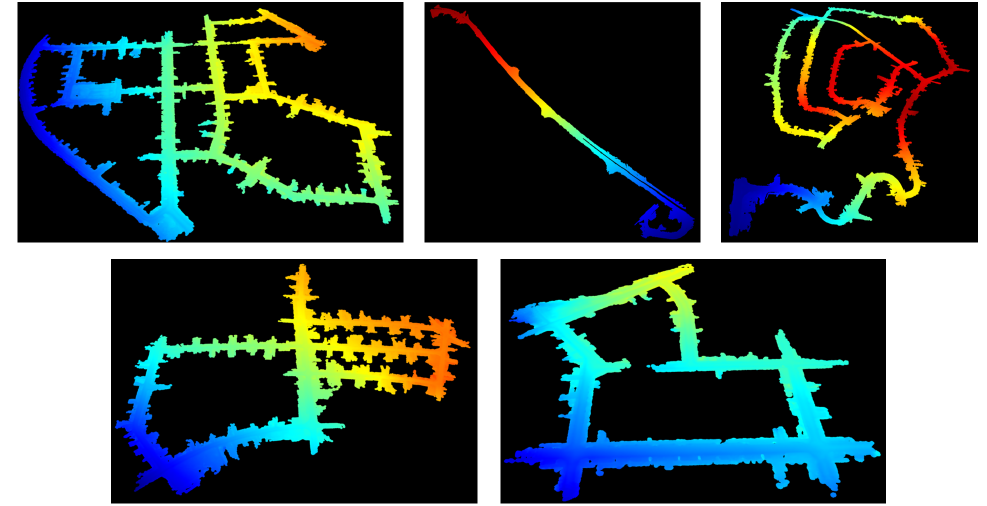
Figure 7. The terrain models generated for the five sequences (00, 01, 02, 05, and 07) in the Se- manticKITTI dataset. Points are colored according to the height